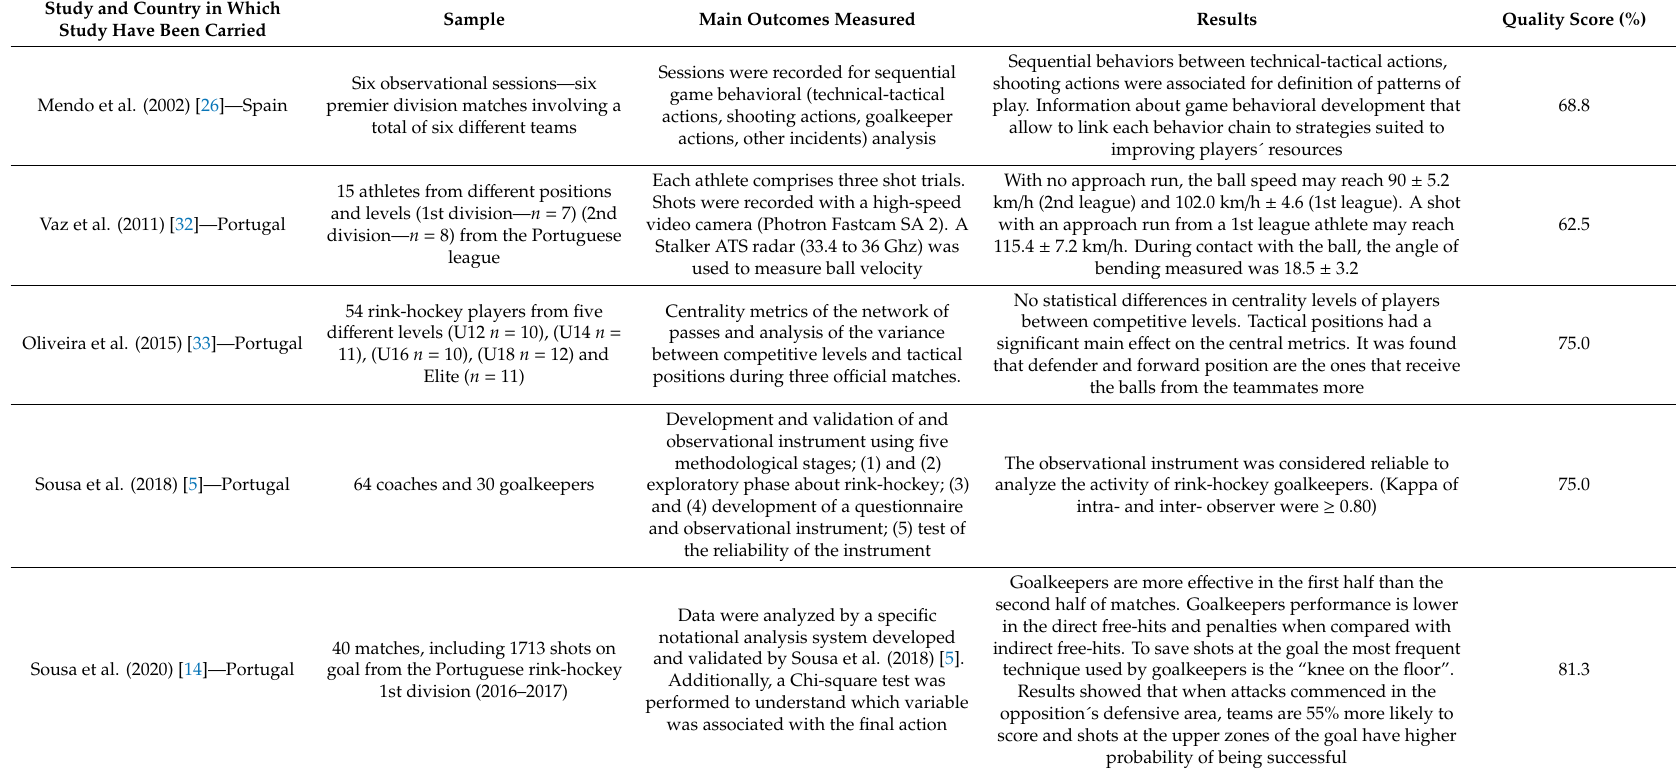
Table 3. Articles predominantly related to the involvement of games characterization (games